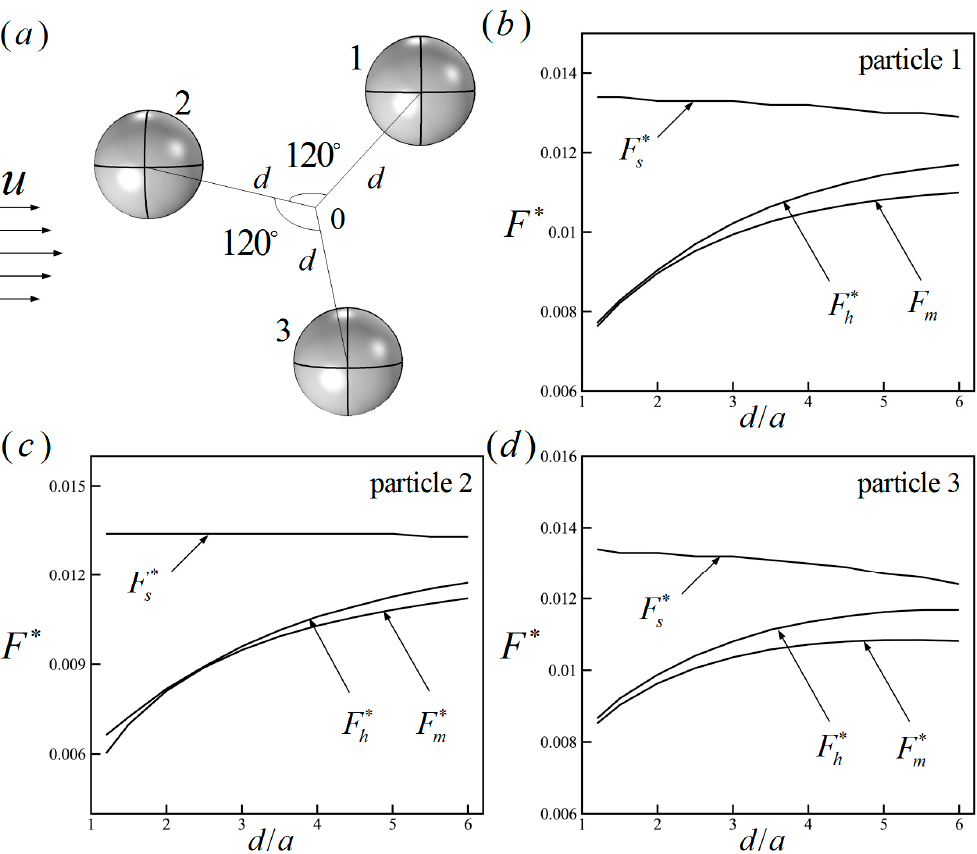
Figure 2. ( a ) The distribution of three particles; ( b – d ) the dimensionless hydrodynamic forces versus the ratio of the distance and the particle radius. F ∗ respectively calculated by integrating the hydrodynamic stress tensor, the traditional Stokes formula and the modified Stokes formula.